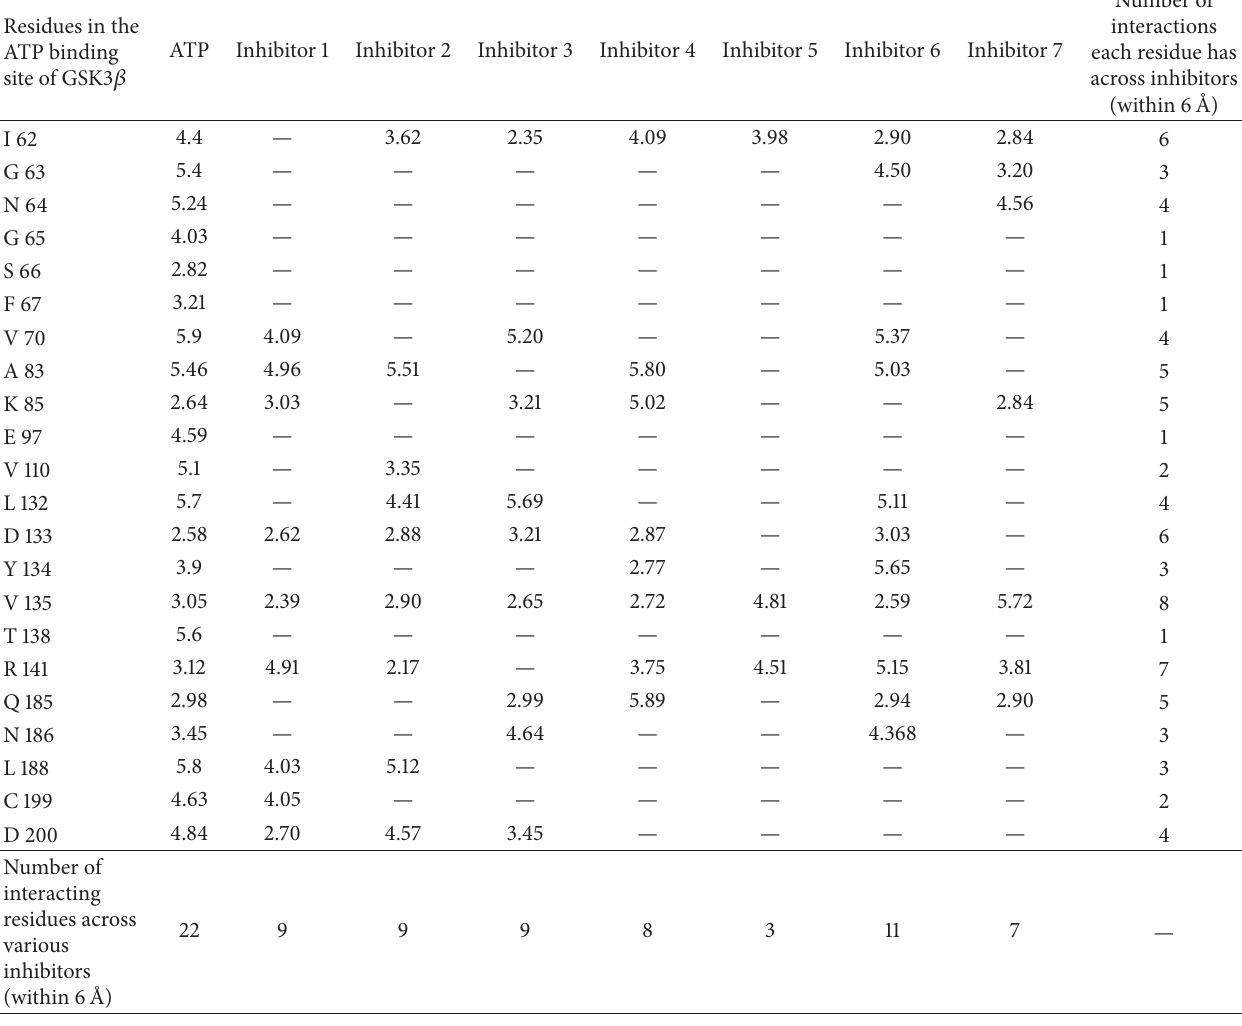
Table 6: Binding site residues of GSK3 𝛽 interacting with 7 inhibitors when docked in the ATP Pocket. Residues in